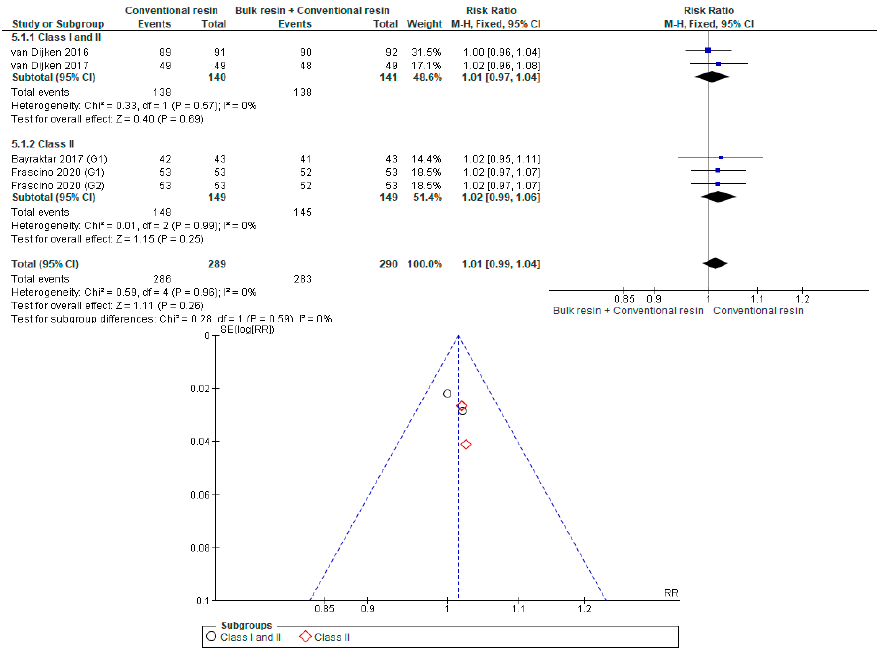
Figure A21. Absence of Secondary Caries: Conventional Resin versus Bulk Resin Covered with Conventional Resin According to Type of Restoration.